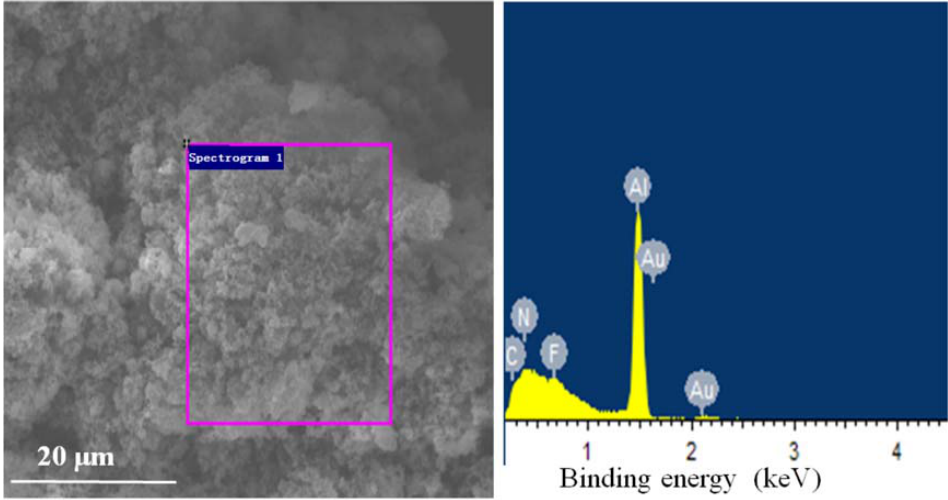
Figure 4. SEM image and EDS spectra of explosive 1.